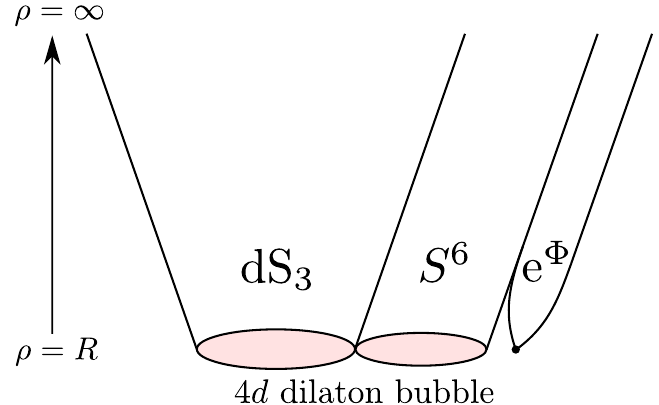
Figure 1: An artistic impression of a "dilaton bubble". According to a 4d observer in its Einstein frame, a BoN is created at finite radius R and starts expanding out towards infinity. At the bubble wall the string coupling shrinks to zero, while the overall size of the internal manifold stays stable.